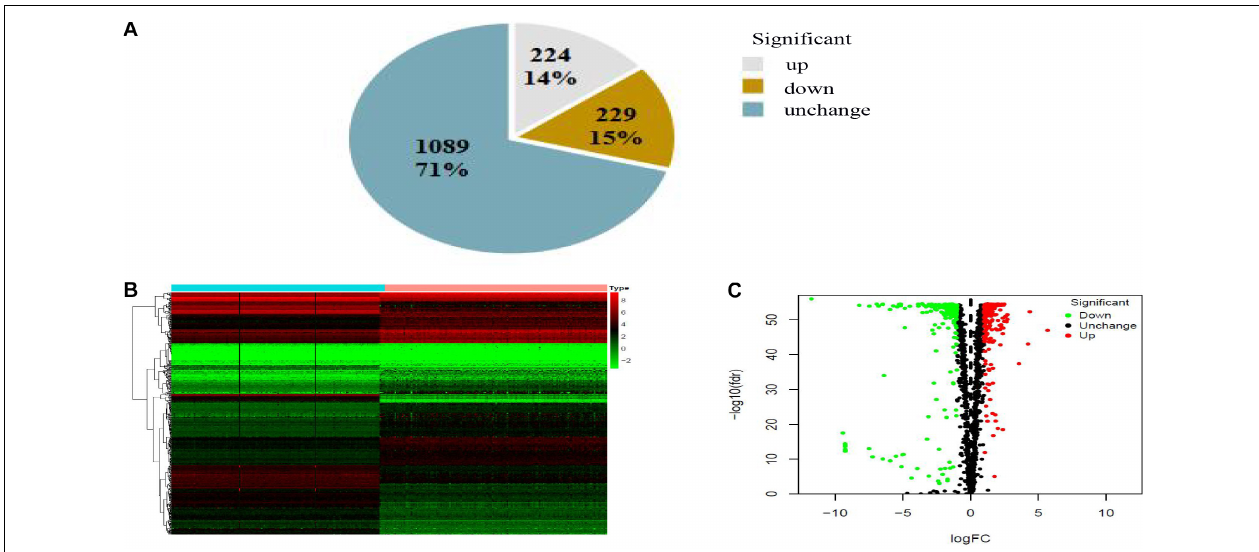
FIGURE 2 | Pie chart (A) , heatmap (B) , and volcano map (C) of RBPs in PAAD. (A) Gray, brown, and blue pieces represented number and percentage of up-, down- and no significant difference RBPs. (B) X - and Y -axes represented samples and RBPs, respectively. Higher, lower, and medium expression of RBPs is shown, respectively, in red, green, and black. Blue and pink bars on top of the heat map indicate normal pancreatic samples and PAAD samples, respectively. (C) Downregulated, upregulated, and no significant difference RBPs in PAAD are shown in green, red, and black dots, respectively. False discovery rate (FDR) < 0.01 and | log 2 FC| > 1 was considered statistically